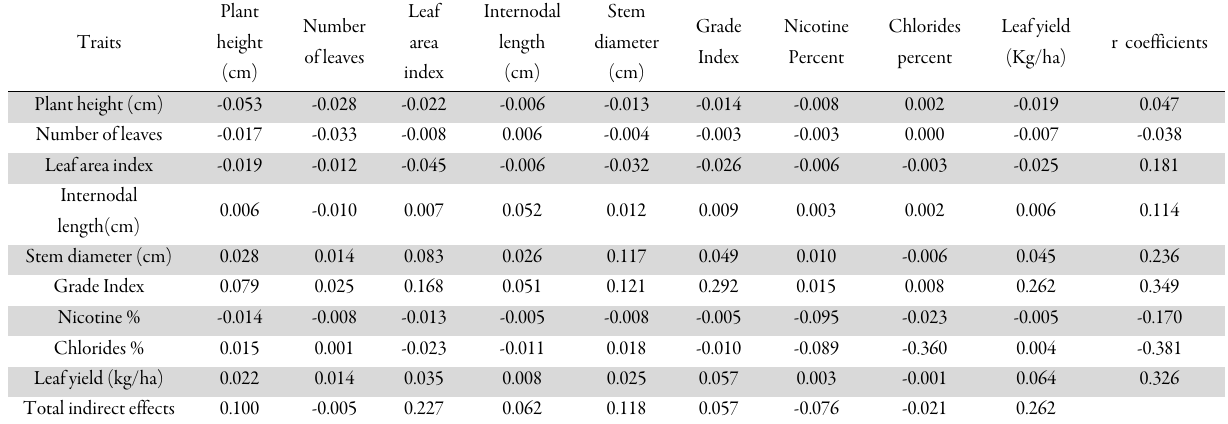
Table 3. Genotypic direct (diagonal) and indirect effects of different quantitative traits in Multi-parent Advanced Generation Inter Cross (MAGIC) F 2 in response to the total